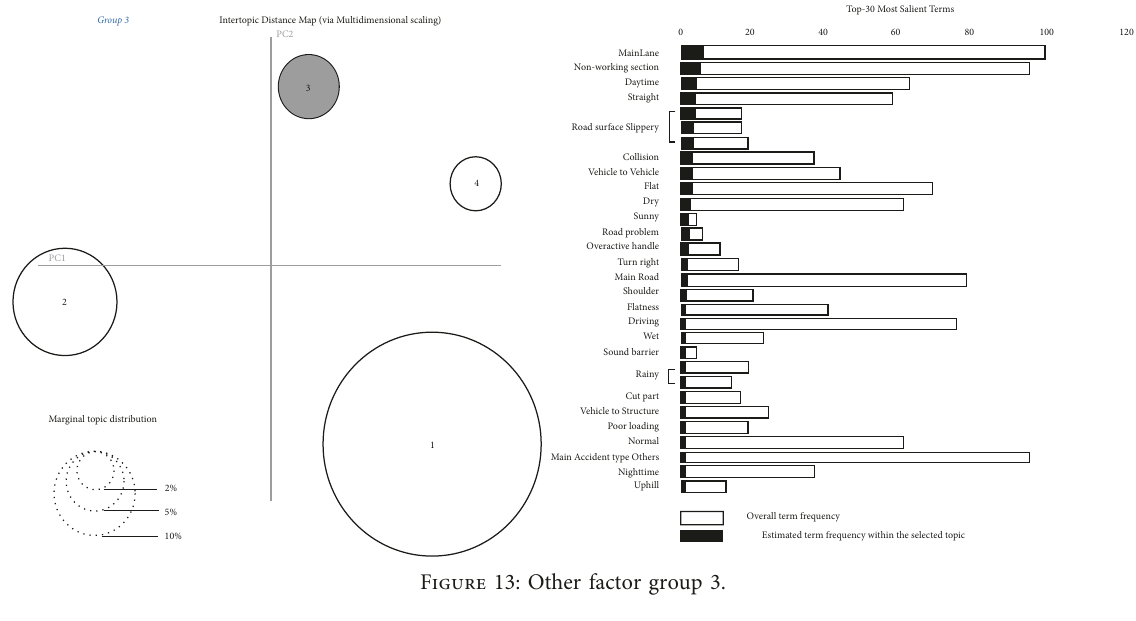
Figure 13: Other factor group